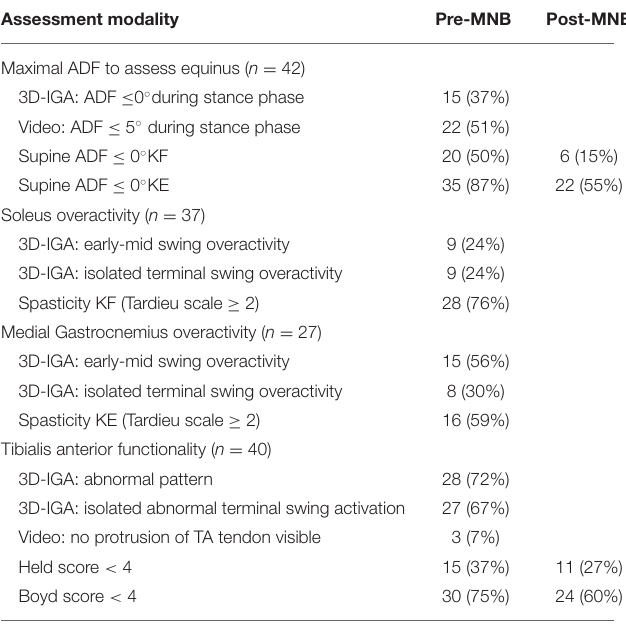
TABLE 2 | Clinical and instrumental assessment of equinus, triceps surae overactivity, and tibialis anterior functionality. Assessment modality